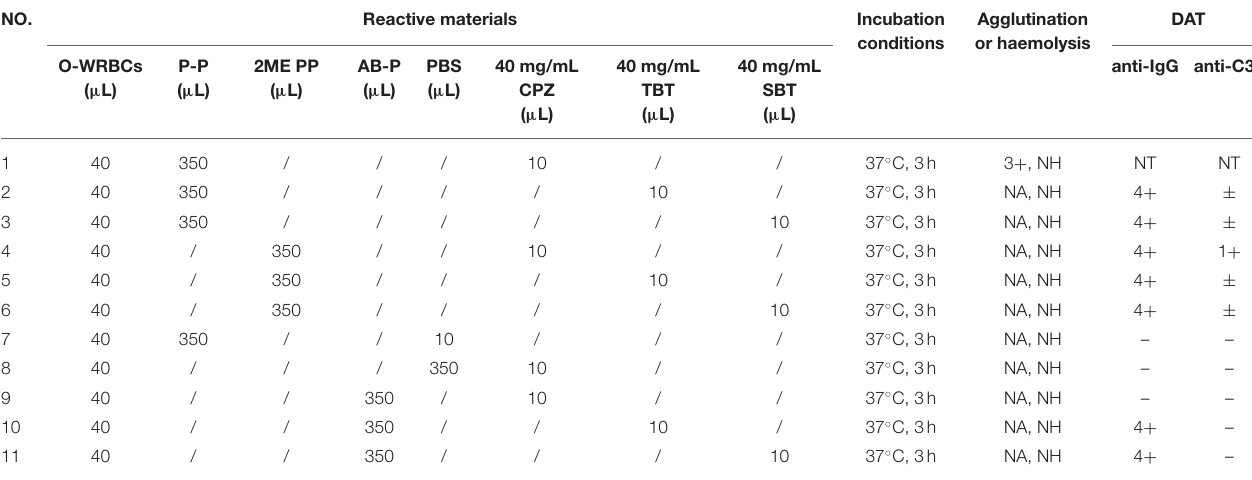
TABLE 3 | In vitro validation of non-immunologic protein adsorption caused by tazobactam and sulbactam.